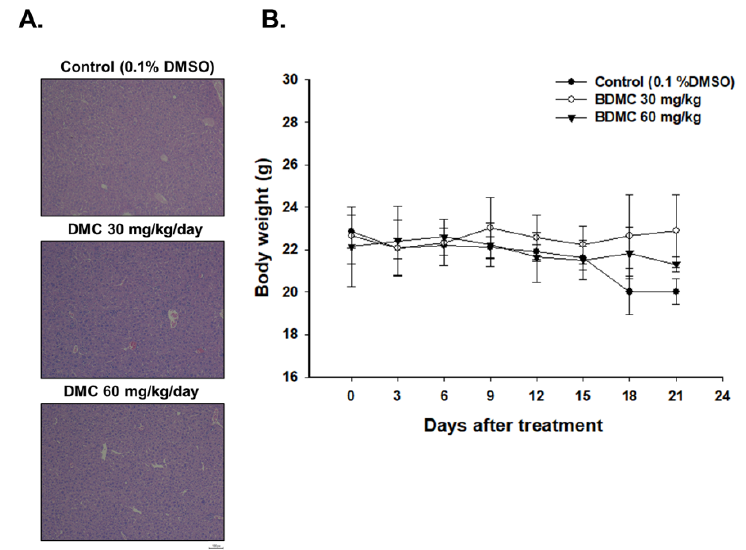
Figure 3. Liver H&E staining and body weights of athymic BALB/c nu/nu nude mice after inocula- tion with GBM 8401/ luc2 cells. ( A ) Bright view microscope image of liver H&E staining from each group (×100). ( B ) Mouse body weight was measured by digital balance every 3 days.